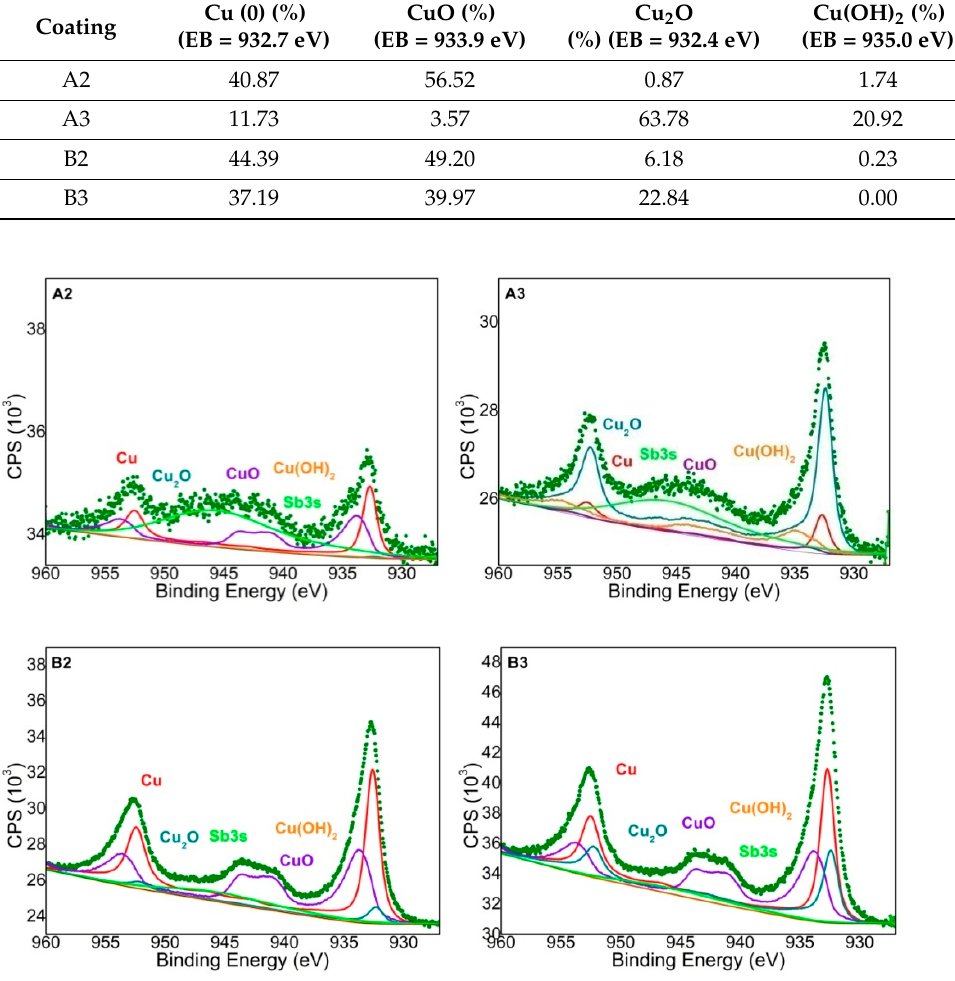
Figure 6. Spectra of A2, A3, B2 and B3 coatings with model spectra for Cu (0), CuO, Cu 2 O and Cu (OH) 2 adjusted to the recorded spectra.